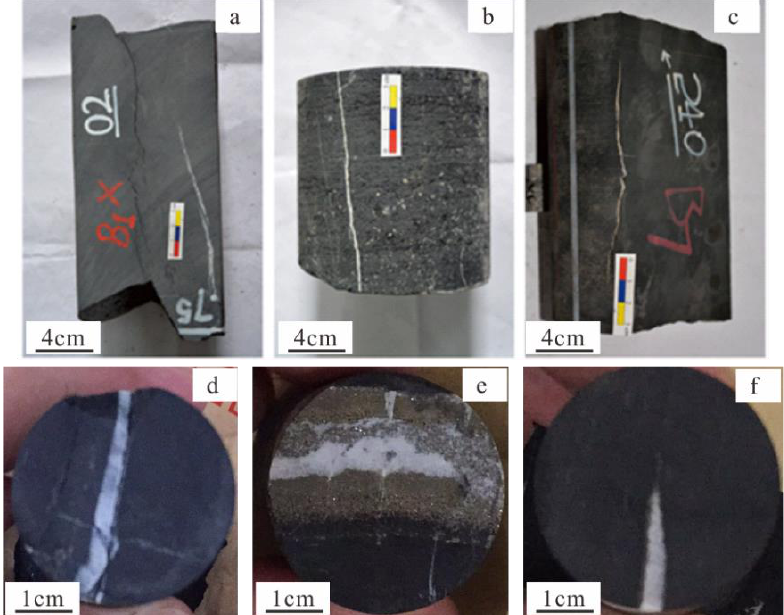
Figure 6. Fracture-filled calcite vein shale sample. ( a ) Longmaxi Formation shale, structural fracture, calcite vein filling; ( b ) Longmaxi Formation shale, structural fracture, and quartz vein filling; ( c ) Longmaxi Formation shale, structural fracture, calcite vein filling; ( d ) Longmaxi Formation shale, calcite vein filling, non-structural fracture; ( e ) Longmaxi Formation shale, filled with pyrite and calcite veins, non-structural fractures; ( f ) Longmaxi Formation shale, calcite vein filling, non-structural fracture.